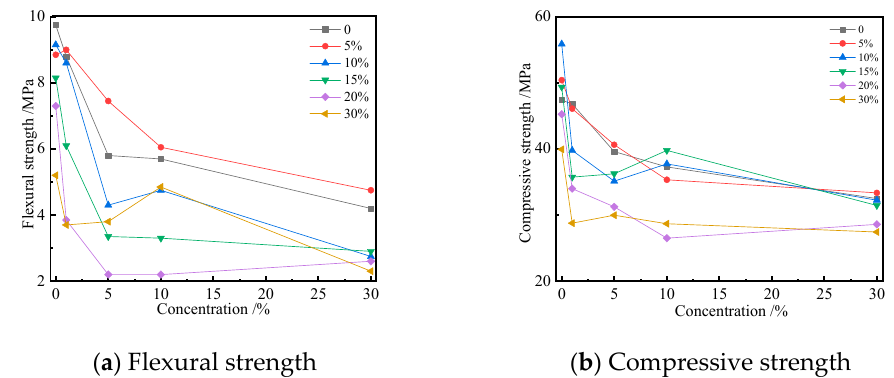
Figure 4. Strength variation of the mortar containing fly ash attacked by different concentrations of sulfate solution for four months.